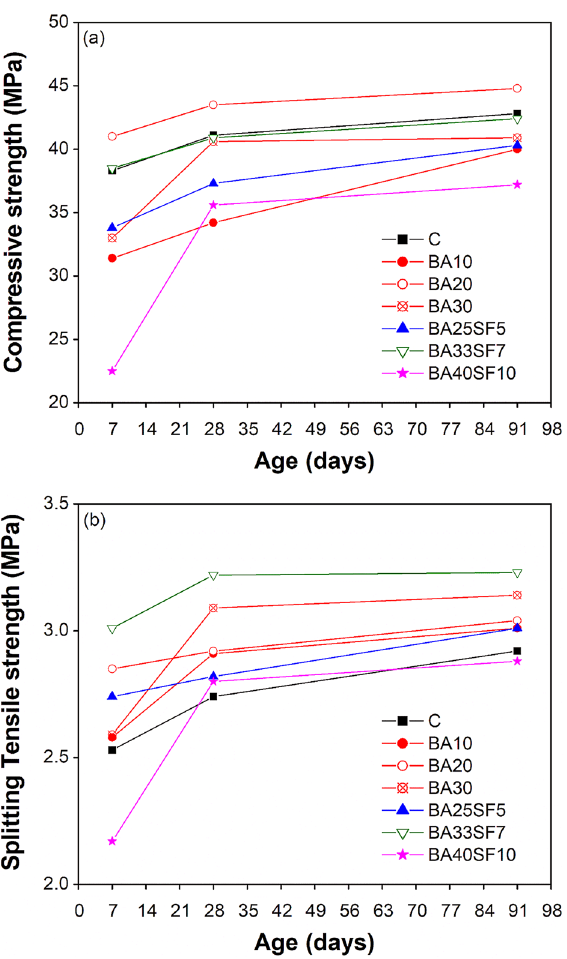
Figure 5. Comparison of strength evolution results between control and other concrete samples of binary and ternary mixes: ( a ) compressive strength, and ( b ) splitting tensile